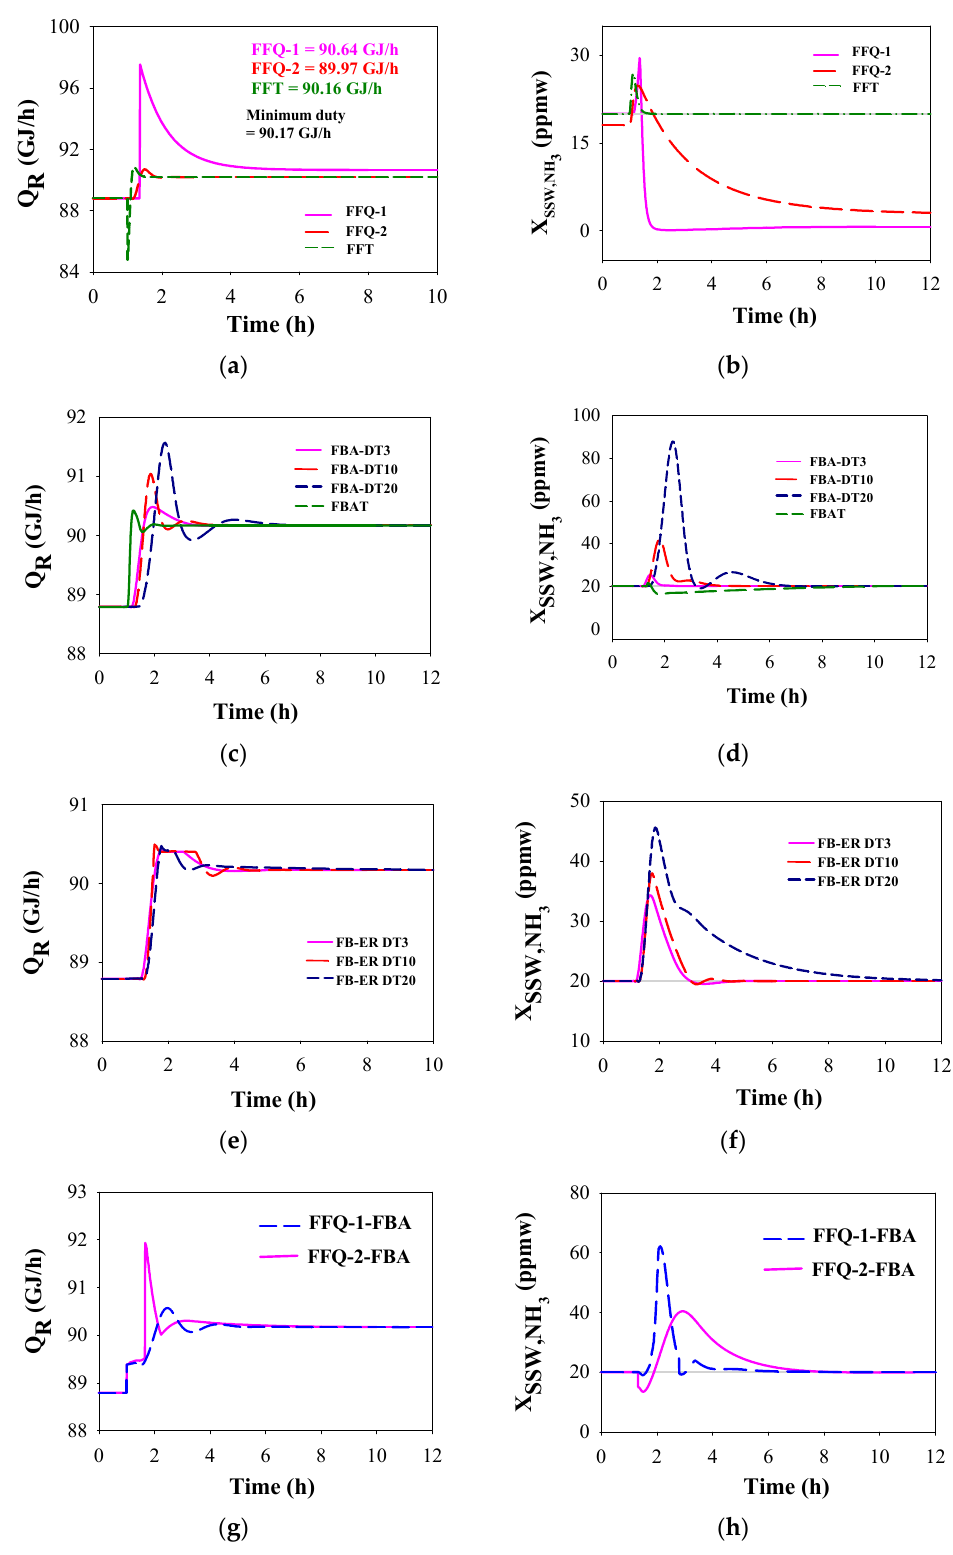
Figure 9. The dynamic responses (reboiler duty and SSW NH 3 concentration) of the SWS employing different control schemes to the sour water feed NH 3 concentration disturbance with +10% change, ( a , b ) for feedforward control, ( c – f ) for feedback control, ( g , h ) for feedforward-feedback